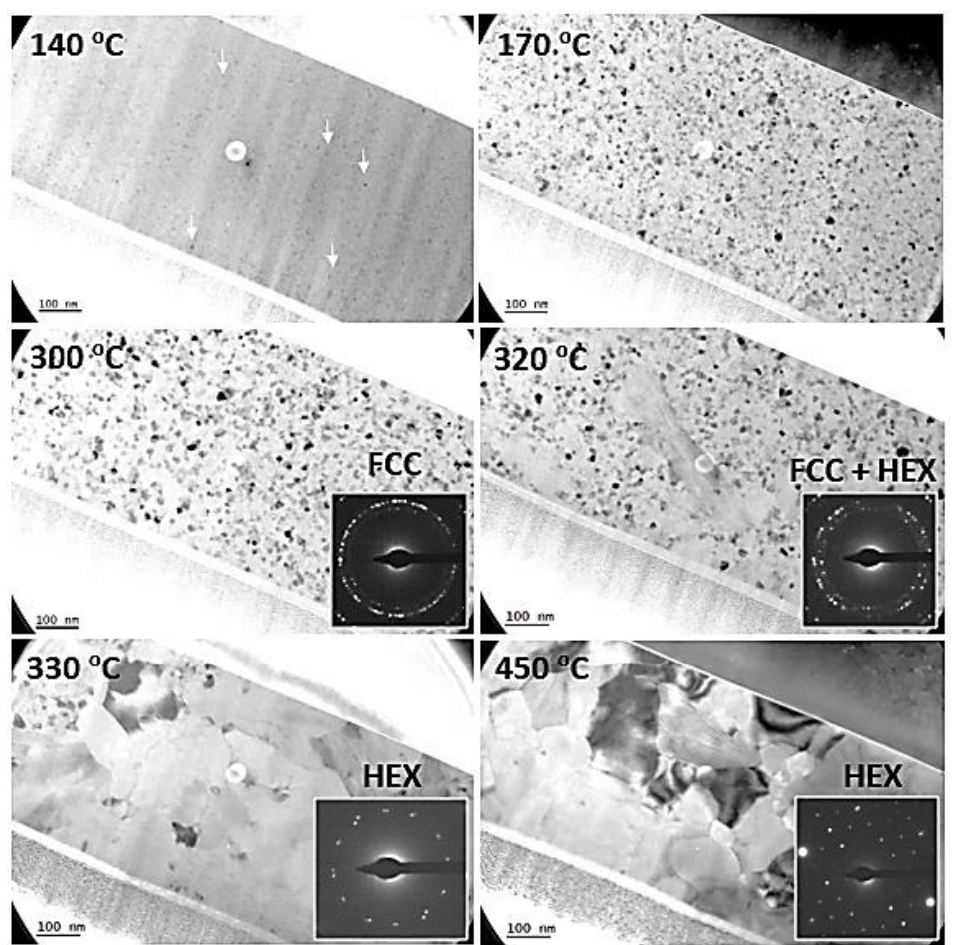
Figure 2. Bright-field (BF) TEM micrographs showing the structure of a pristine Ge 2 Sb 2 Te 5 layer during the increase in the annealing temperature during the in situ experiment. The inserts show the associated SAED patterns. “FCC” and “HEX” refer to the face-centered cubic and hexagonal structures, respectively.